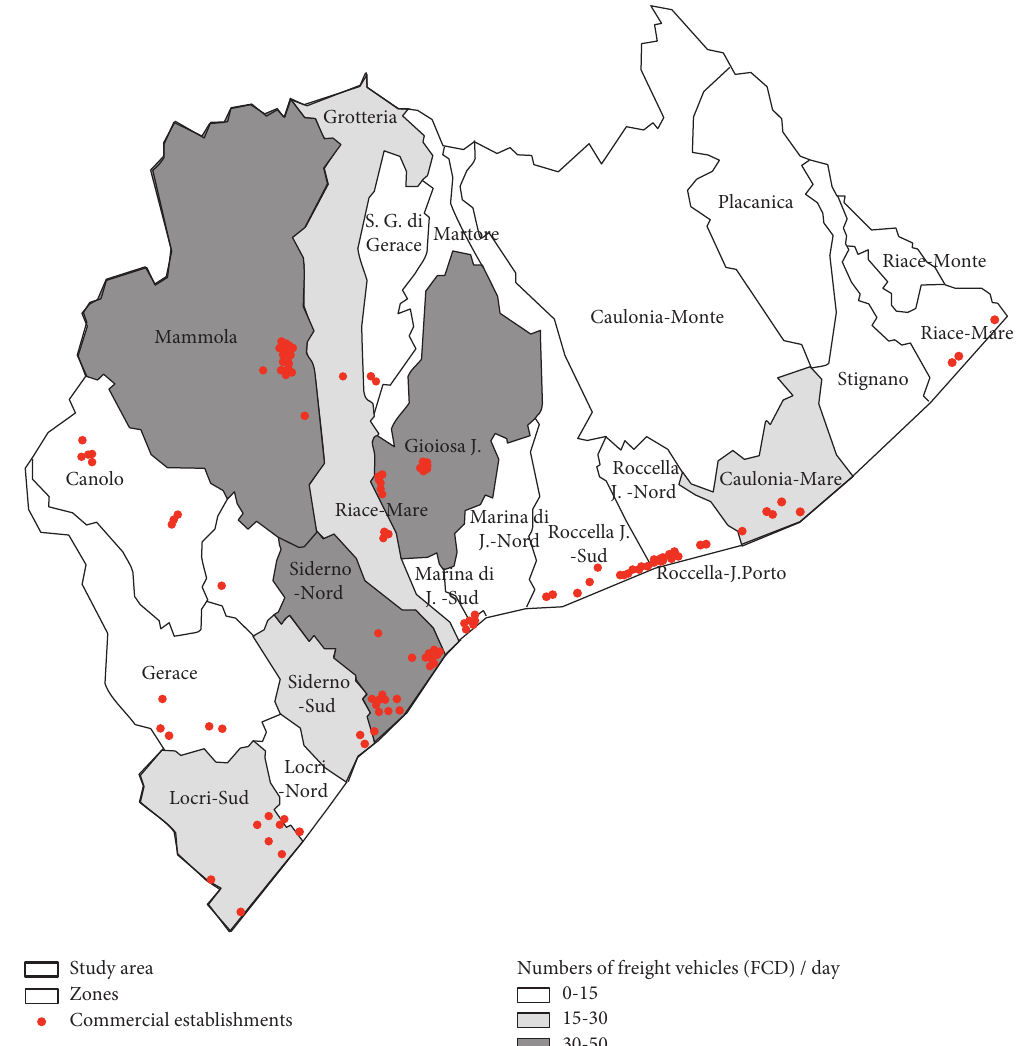
Figure 2: Study area, zoning, commercial establishments (red dots), and number of freight vehicles having a zone as destination per